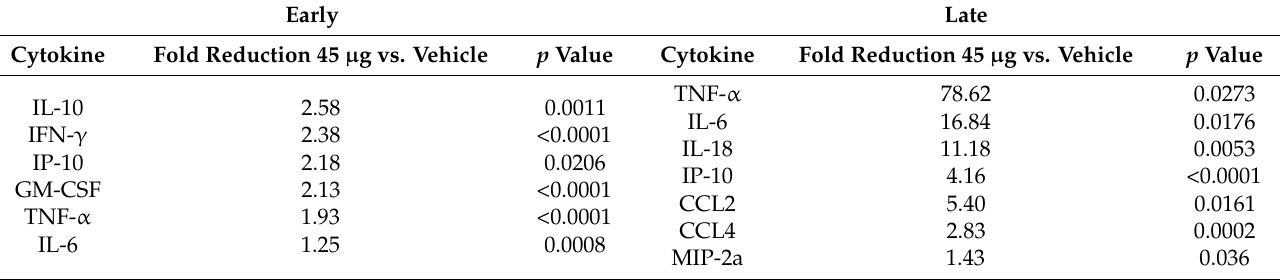
Table 1. Inflammatory markers induced by SARS-CoV-2 in mice in the vehicle group and suppressed in the mice that received two doses of 45 µ g CoV-RBD121-NP. Early represents analysis of pooled sera from mice collected four days post-challenge; late represents analysis of serum from each mouse collected on day 10 or at virus-induced death. Statistical differences were determined by one-way ANOVA with Tukey’s post hoc test. Vehicle group, n = 7; CoV-RBD121-NP 45 µ g, n = 10.